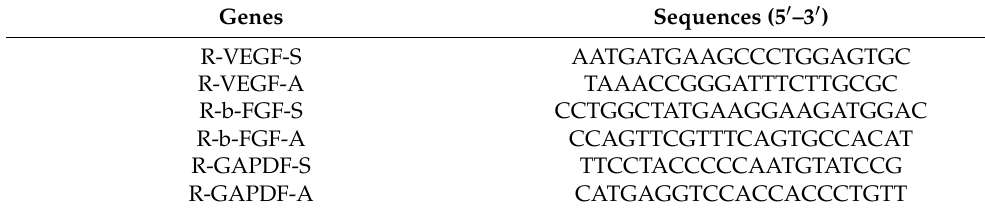
Table 1. Primers used for